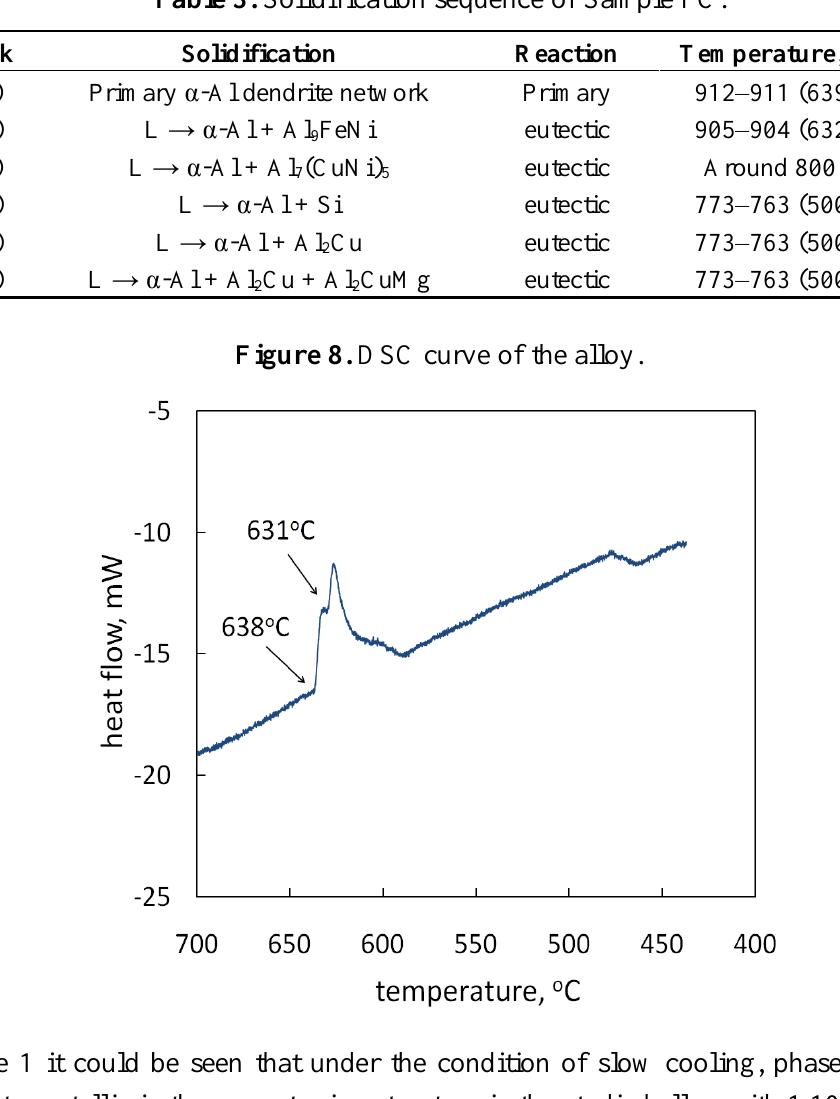
Figure 8. Two reaction peaks were observed on the DSC curve at 638 and 631 °C. Upon cooling from